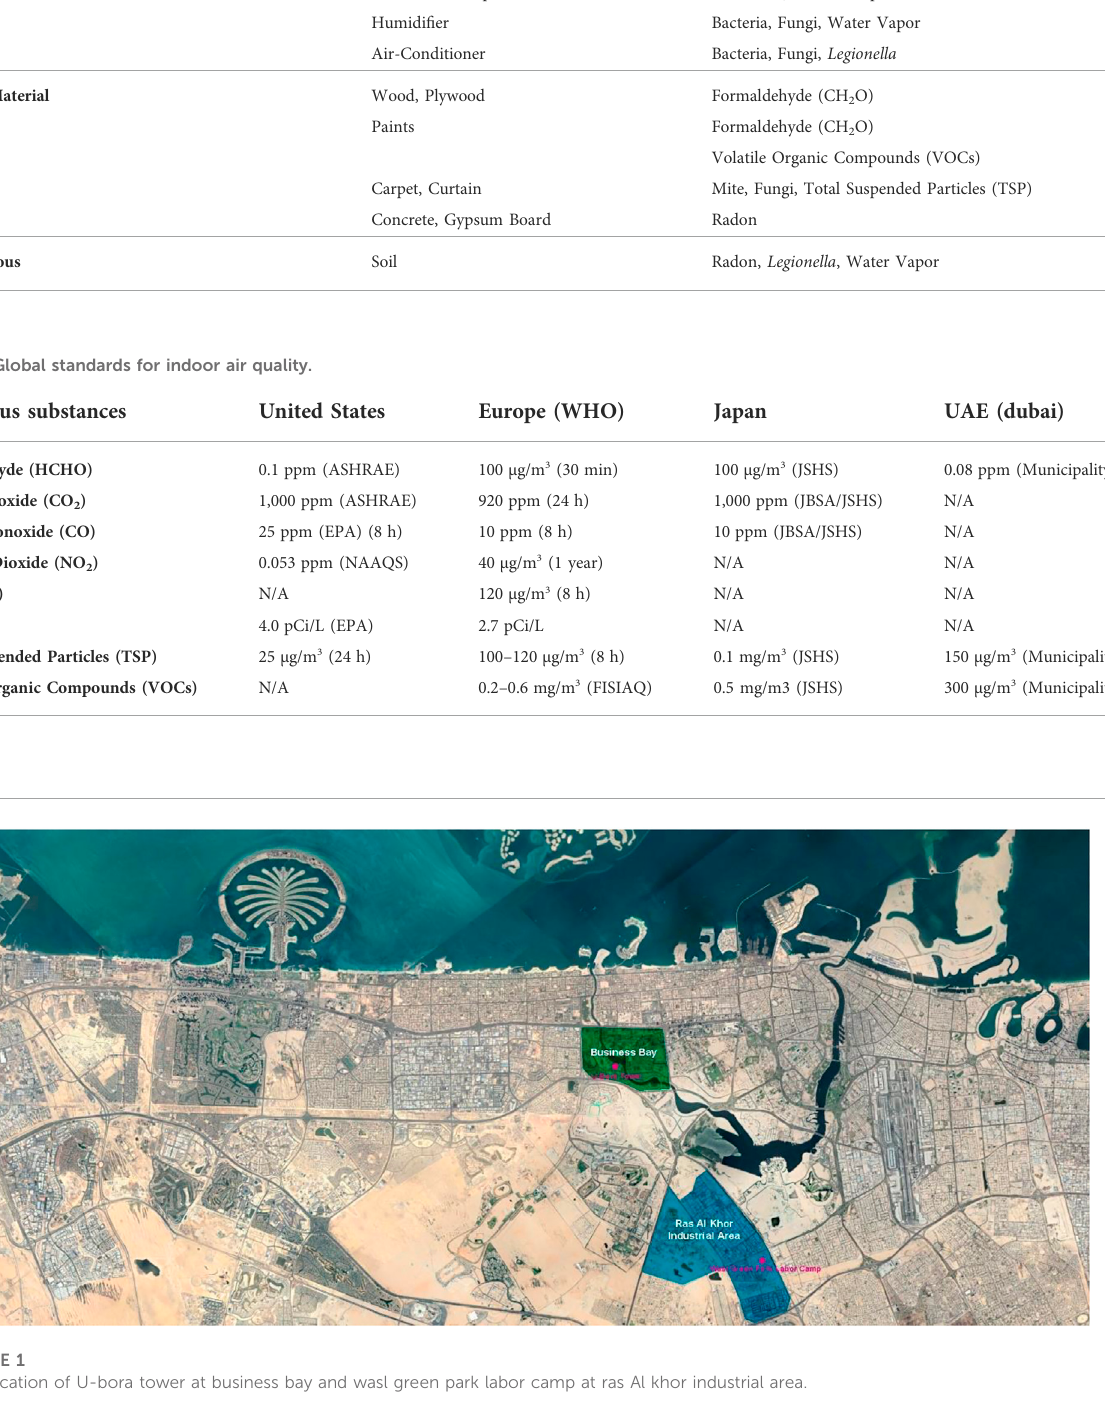
Frontiers in Built